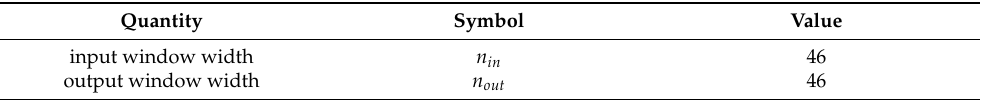
Table 6. Grid search settings with adjusted window